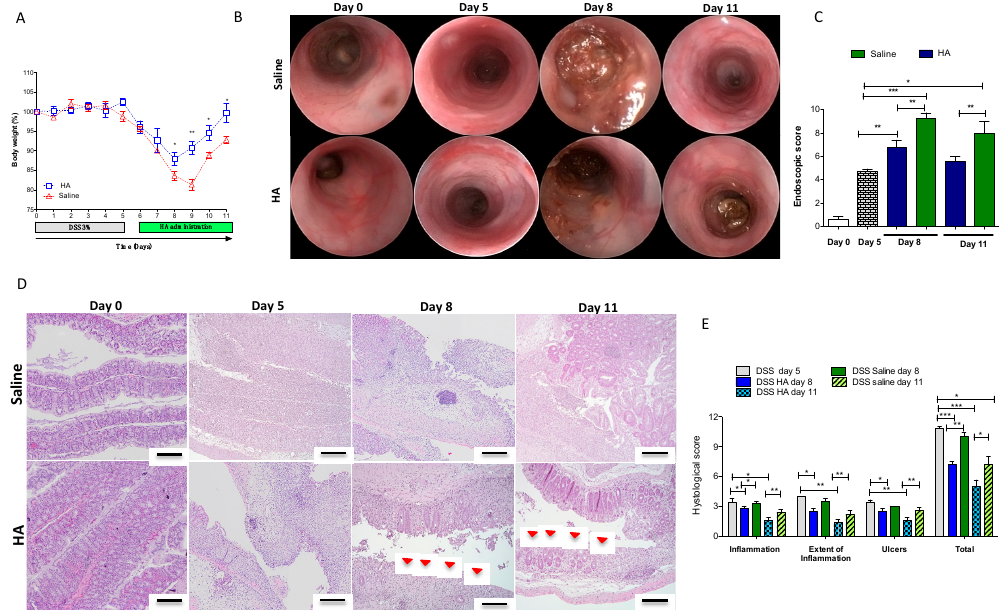
Figure 2. HA treatment accelerated the recovery phase of acute colitis. Acute colitis was induced in C57BL/6N wild type mice by 3% DSS administration in drinking water ad libitum for 5 days. After